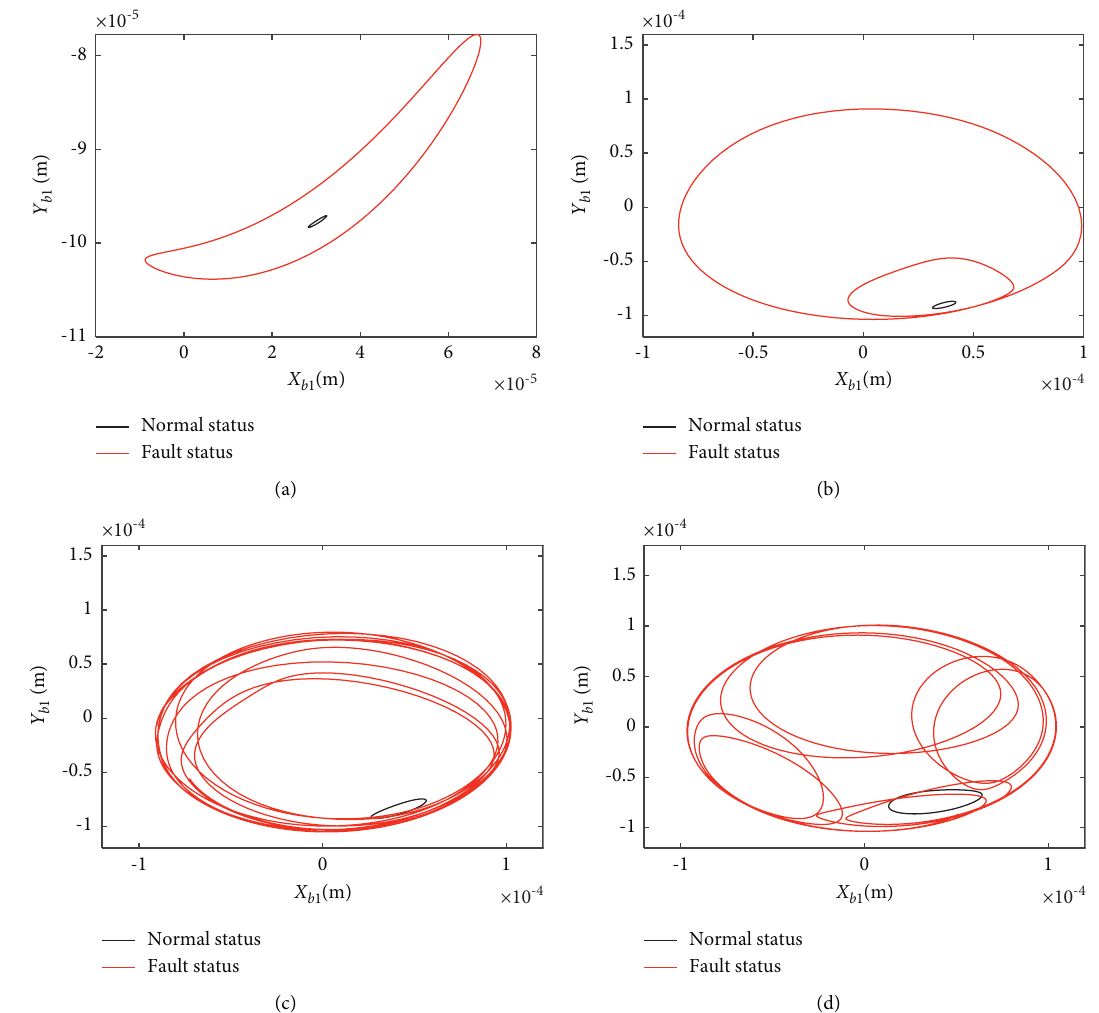
Figure 8: Axis trajectory diagram of bearing position: (a) 2000rpm; (b) 5000rpm; (c) 8000rpm; (d) 18000rpm.